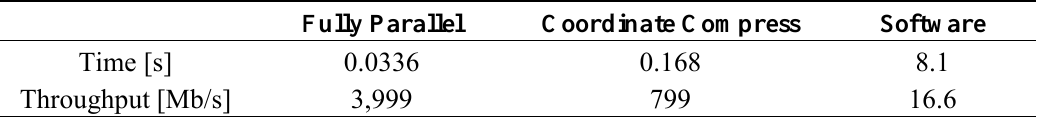
Table 2. Comparison of data throughput of different